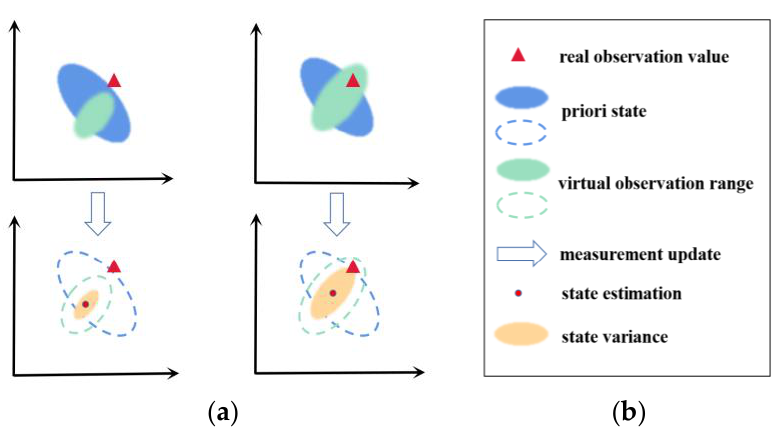
Figure 4. Relationship between a space’s virtual observation (green ellipse) and real observation (red triangle), as well as measurement updates from motion constraints; ( a ) little constraint value; ( b ) large constraint value.